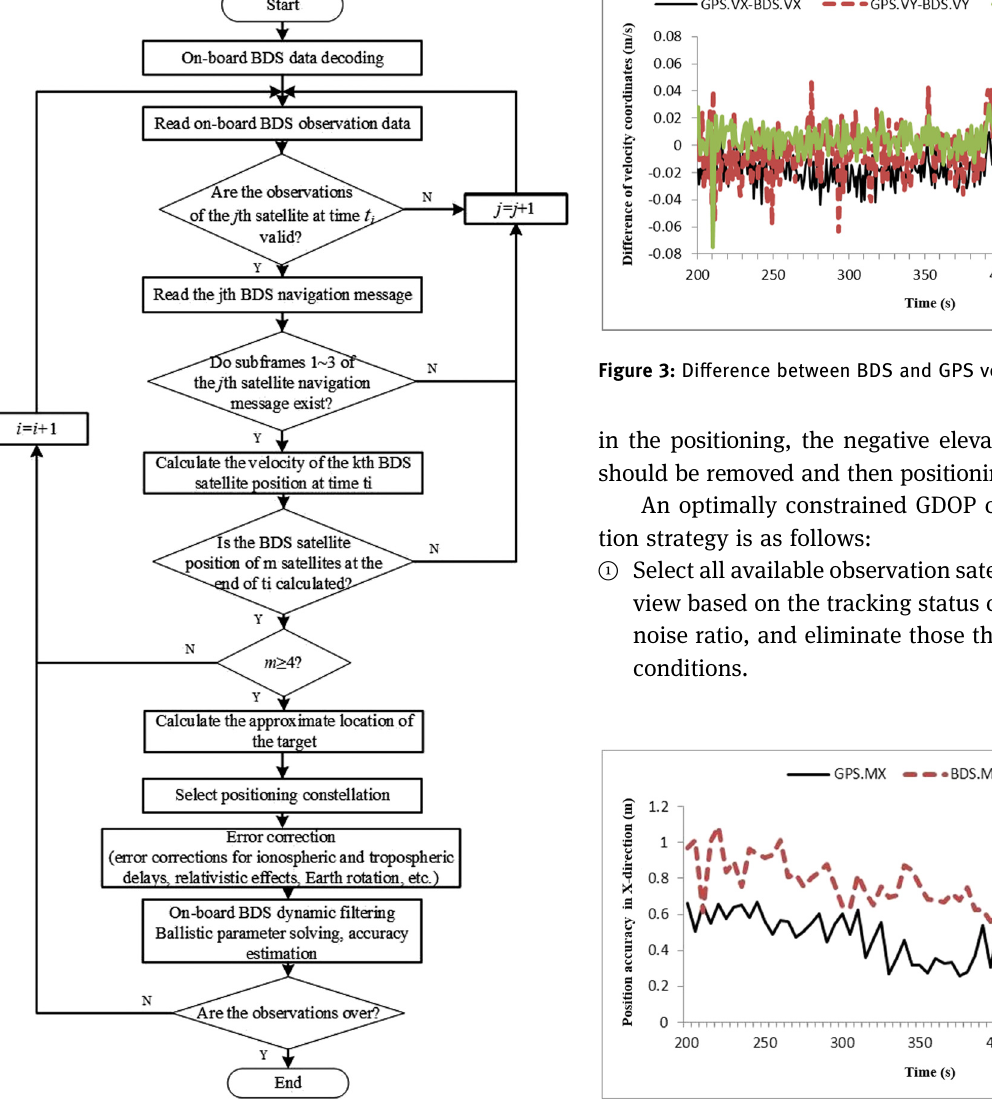
Figure 1: Ballistic solving process of on - board BDS.